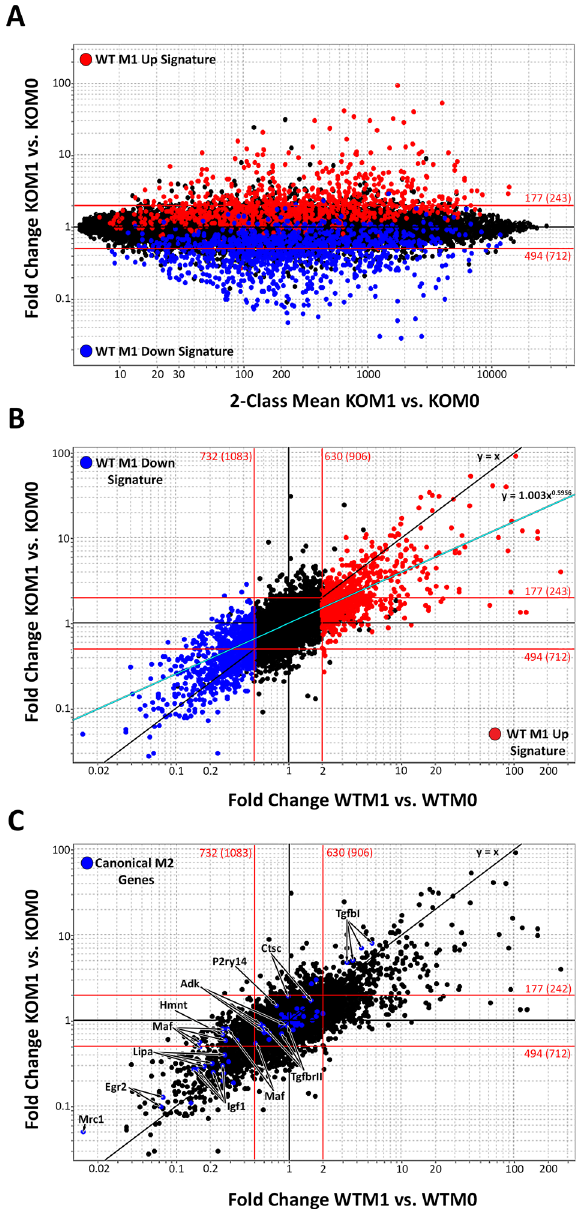
Fig 5. miR-155 is required for expression of the full classically activated macrophage signature. ( A ) Fold Change (FC) vs. Mean Expression Value (MEV) plot of knockout (KO) M1 vs. M0 microarray data, with highlighted classical wild-type (WT) M1 signature genes as defined in this study. Genes more than 2FC up- regulated in WT M1 macrophages (red genes in Fig 4A ) are shown in red and genes more than 2FC down- regulated in WT M1 macrophages (blue genes in Fig 4A ) are shown in blue. ( B ) WT M1/M0 FC vs. KO M1/ M0 FC plot highlighting the WT M1 Up signature (in red) and WT M1 Down signature (in blue). The black line indicates the x = y trendline expected if all gene probes were similarly up- or down-regulated exactly the same in KO M1 and WT M1 macrophages (FC KO M1 vs KO M0 = FC WT M1 vs WT M0). The blue line indicates the power regression trendline that genes more closely adhered to, represented by y = 1 . 003x 0 . 5956 , R 2 = 0.50052. ( C ) WT M1/M0 FC vs. KO M1/M0 FC plot highlighting classical M2 genes. Red lines represent a +/- 2FC cut-off. More than a single appearance of a gene symbol indicates different probes hybridizing the same gene transcript were